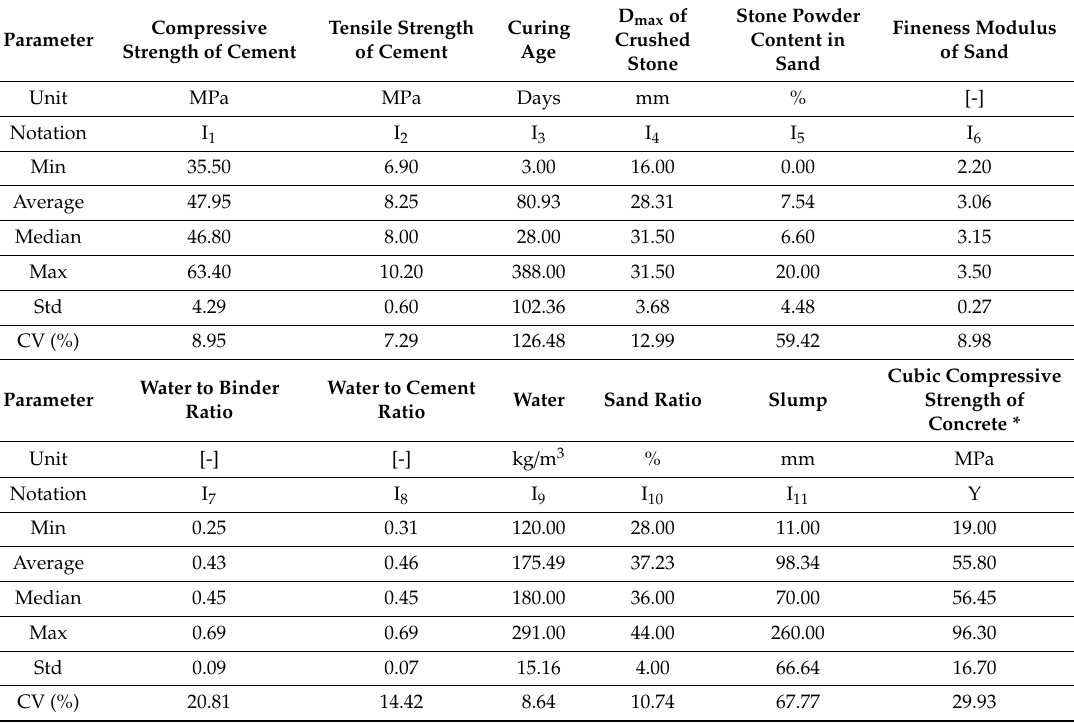
Table 1. Statistical analysis of inputs and output used in this